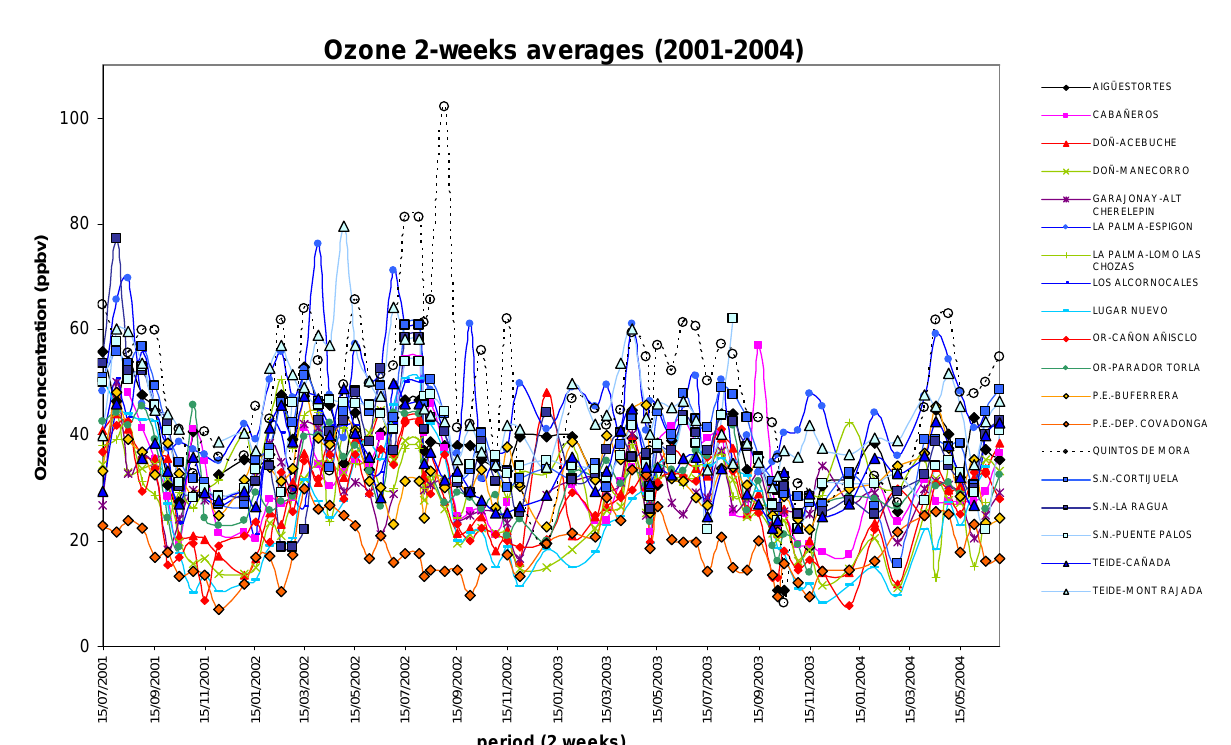
Ozone 2-weeks averages (2001-2004)